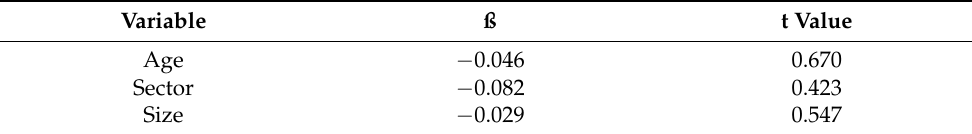
Table 7. Control